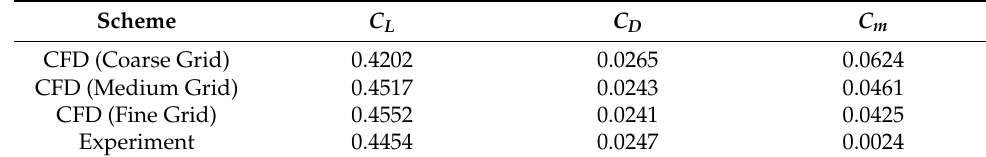
Table 2. Influence of grid size on aerodynamic characteristics.